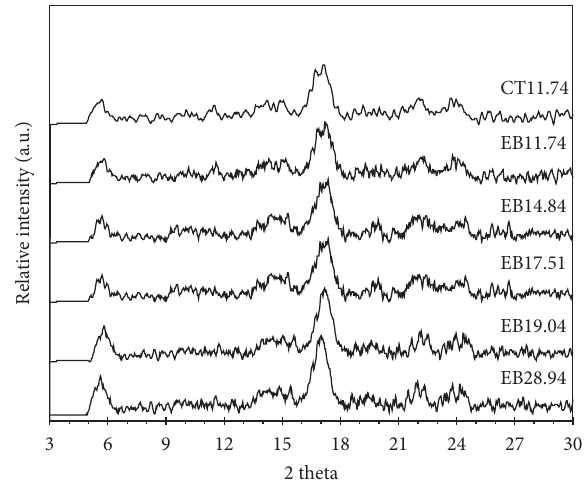
Figure 1: X-ray diffraction patterns of starch